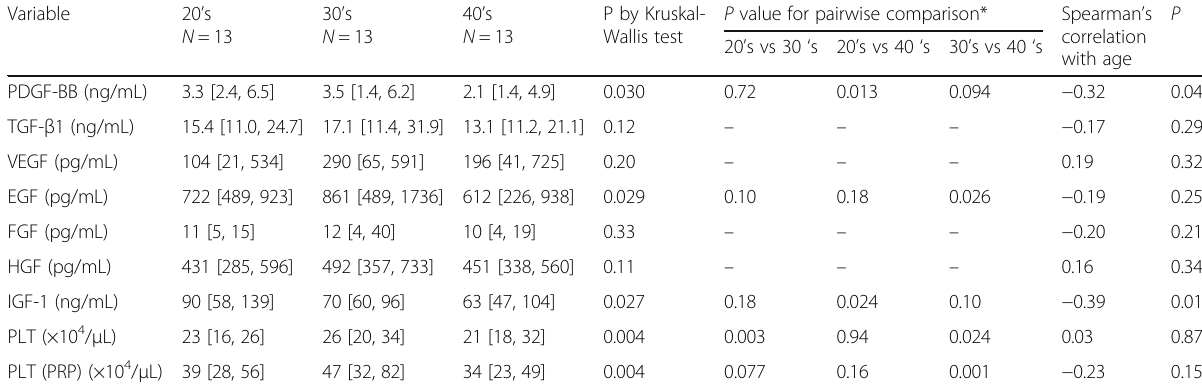
Table 2 Statistics including correlation with age for 10 analytes Variable